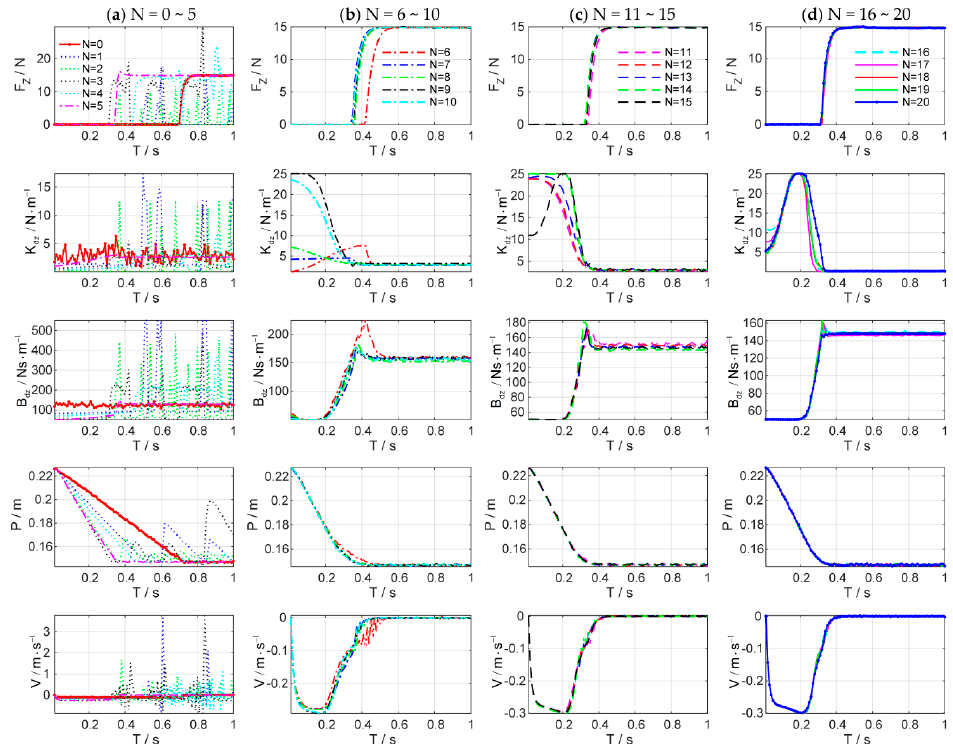
Figure 9. Learning process of the total 20 learning iterations. The first row: contact force in z -axis direction; the second row: Cartesian stiffness schedules; the third row: Cartesian damping schedules; the fourth row: position of the end-effector in z -axis direction; the fifth row: velocity of the end-effector in z -axis direction.